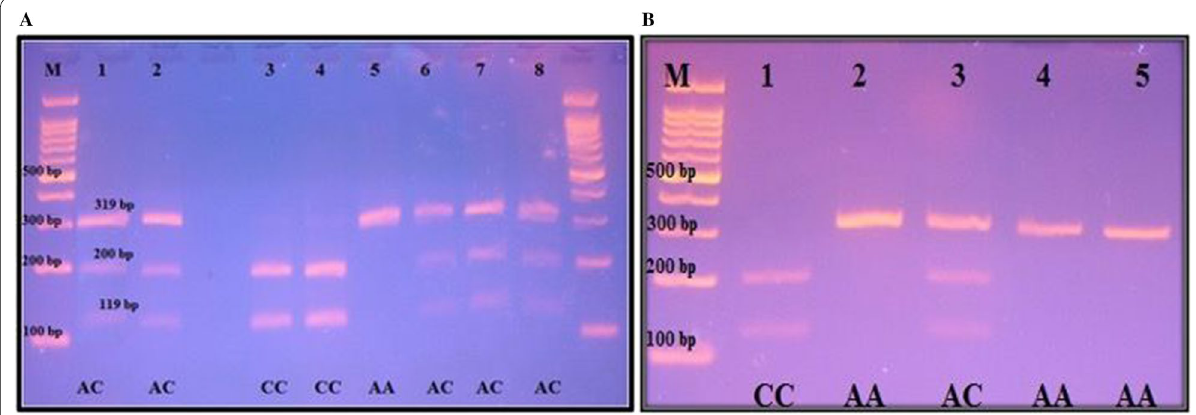
Fig. 1 1513A/C polymorphism in the P2X7 gene was detected by RFLP analysis. Heterozygote AC genotype produced products of 319, 200 and 119 base pair (bp), homozygote wild AA genotype produced digested products of 319 bp and homozygote mutant CC genotype produced digested products of 200 and 119 bp. Lane M, 100 bp